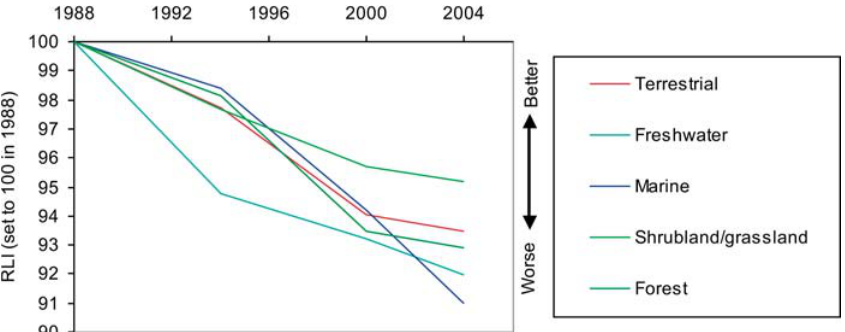
Figure 5. RLIs for Birds in Different Habitats Sample sizes: terrestrial, 206 genuine status changes/2,329 species in categories Extinct in the Wild to Near Threatened in at least one assessment; freshwater, 31/ 226; marine, 12/133; shrubland/grassland, 45/481; forest, 169/1,513.